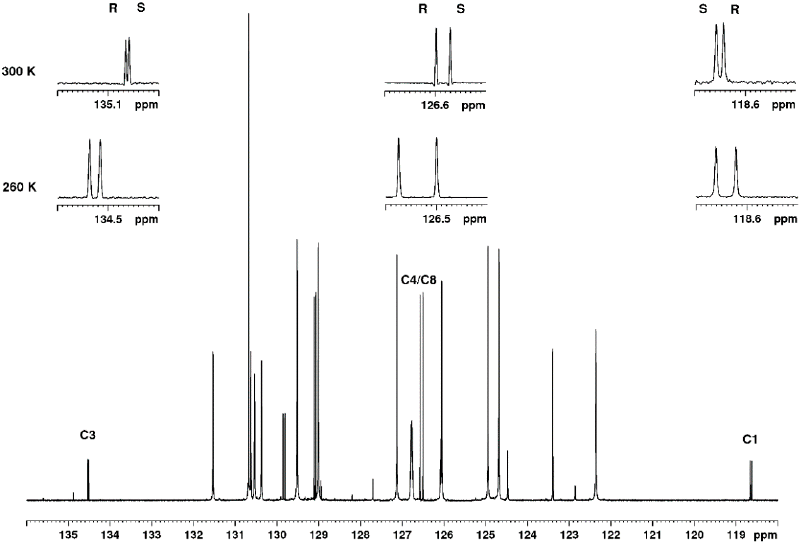
Figure 2. Low field region of the 13 C NMR spectrum of a mix of R and S mandelonitrile, 260 K with TFAE. The expansions show the signals of from left to right C3, C4/C8 and C1 at 260 K and at 300 K. The assignment of R and S is given.